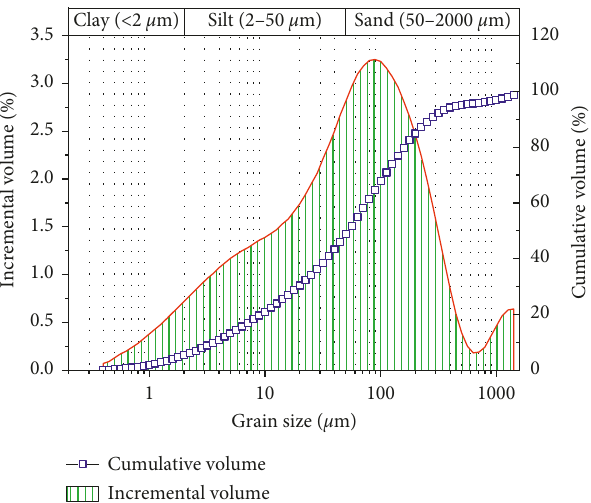
Figure 1: Grain size distribution curve of the tailings.